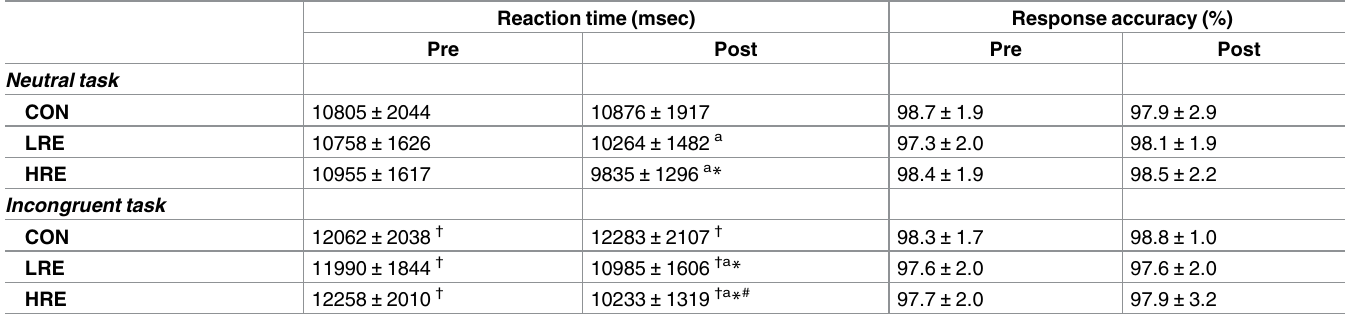
Table 4. Changes in reaction time and response accuracyat the